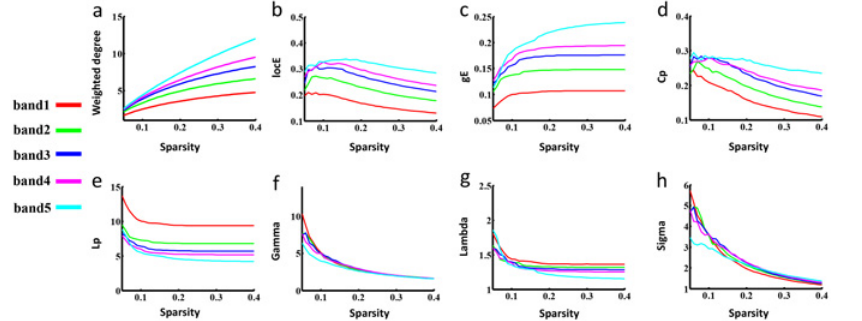
Fig 8. Small world properties in the frequency specific FCNs using REST. Fig 8 show the plot of global topological patterns of distinct frequency intervals (y-axis) separated by a conventional ideal rectangular window band-pass filter versus sparsity (x-axis). The meaning of these figures is the same as in Fig 3.